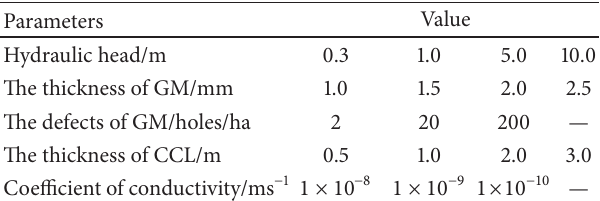
Figure 3: The concentration-depth curves of the Cd 2+ . Table 5: Variables for parametric